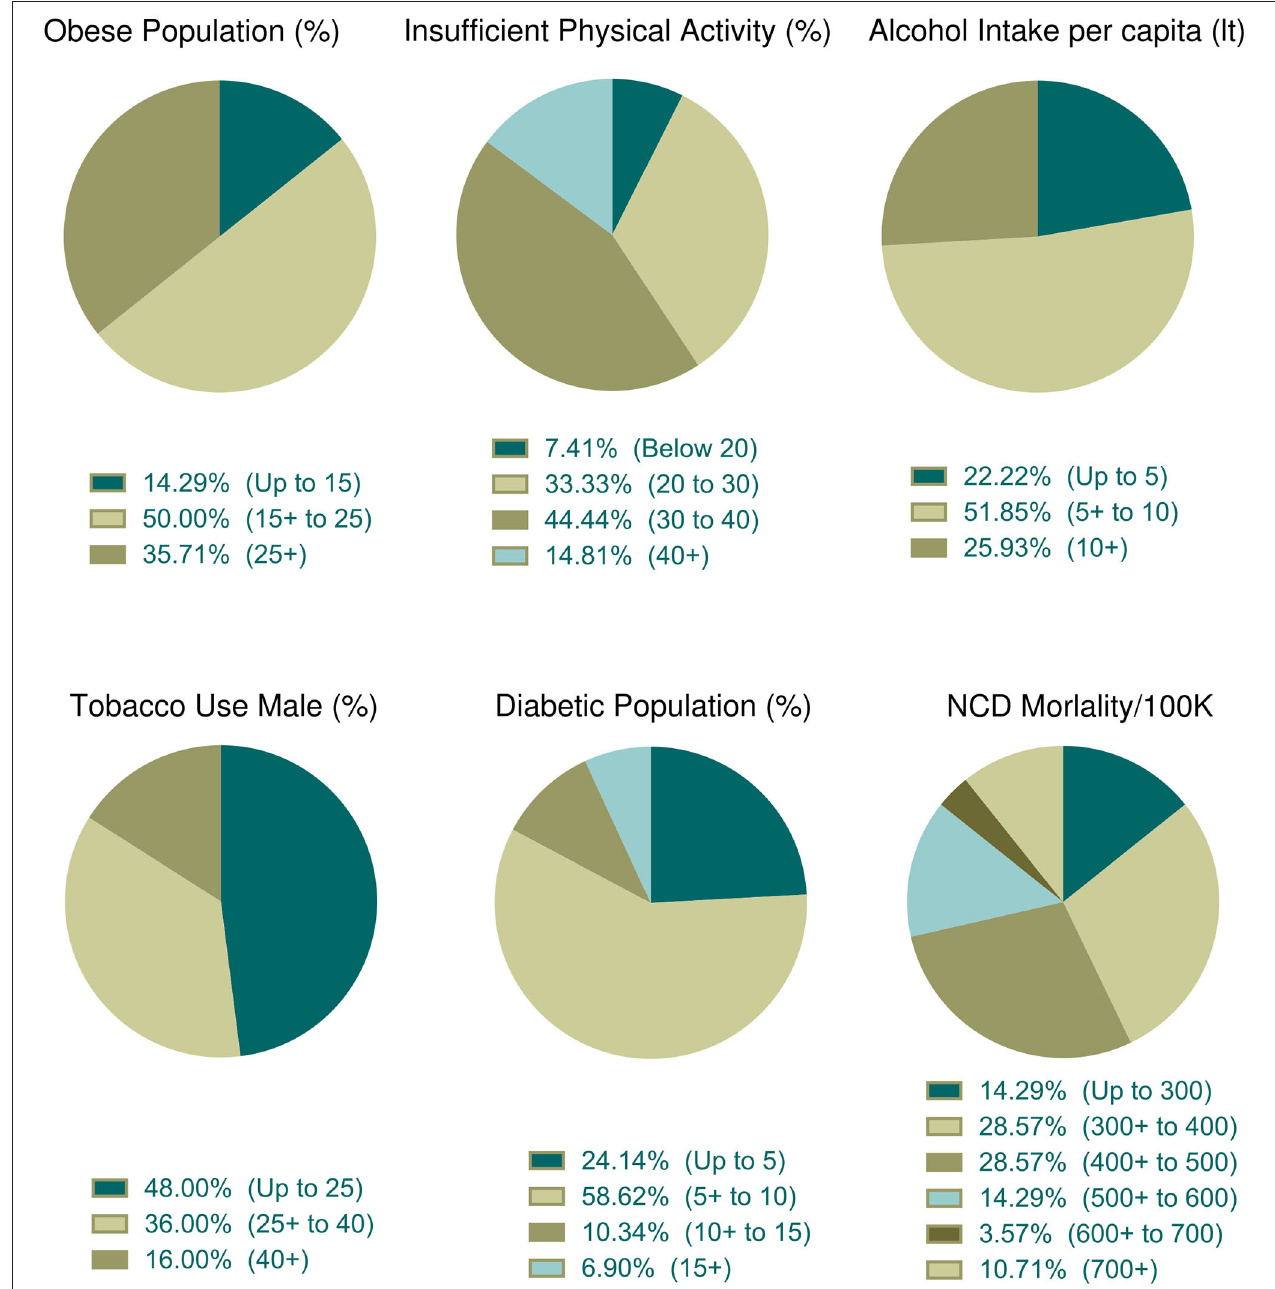
FIGURE 7 | Distribution of health indicators incidence among the top thirty countries with high case fatality (%). Data categories with zero data are not shown in the pie